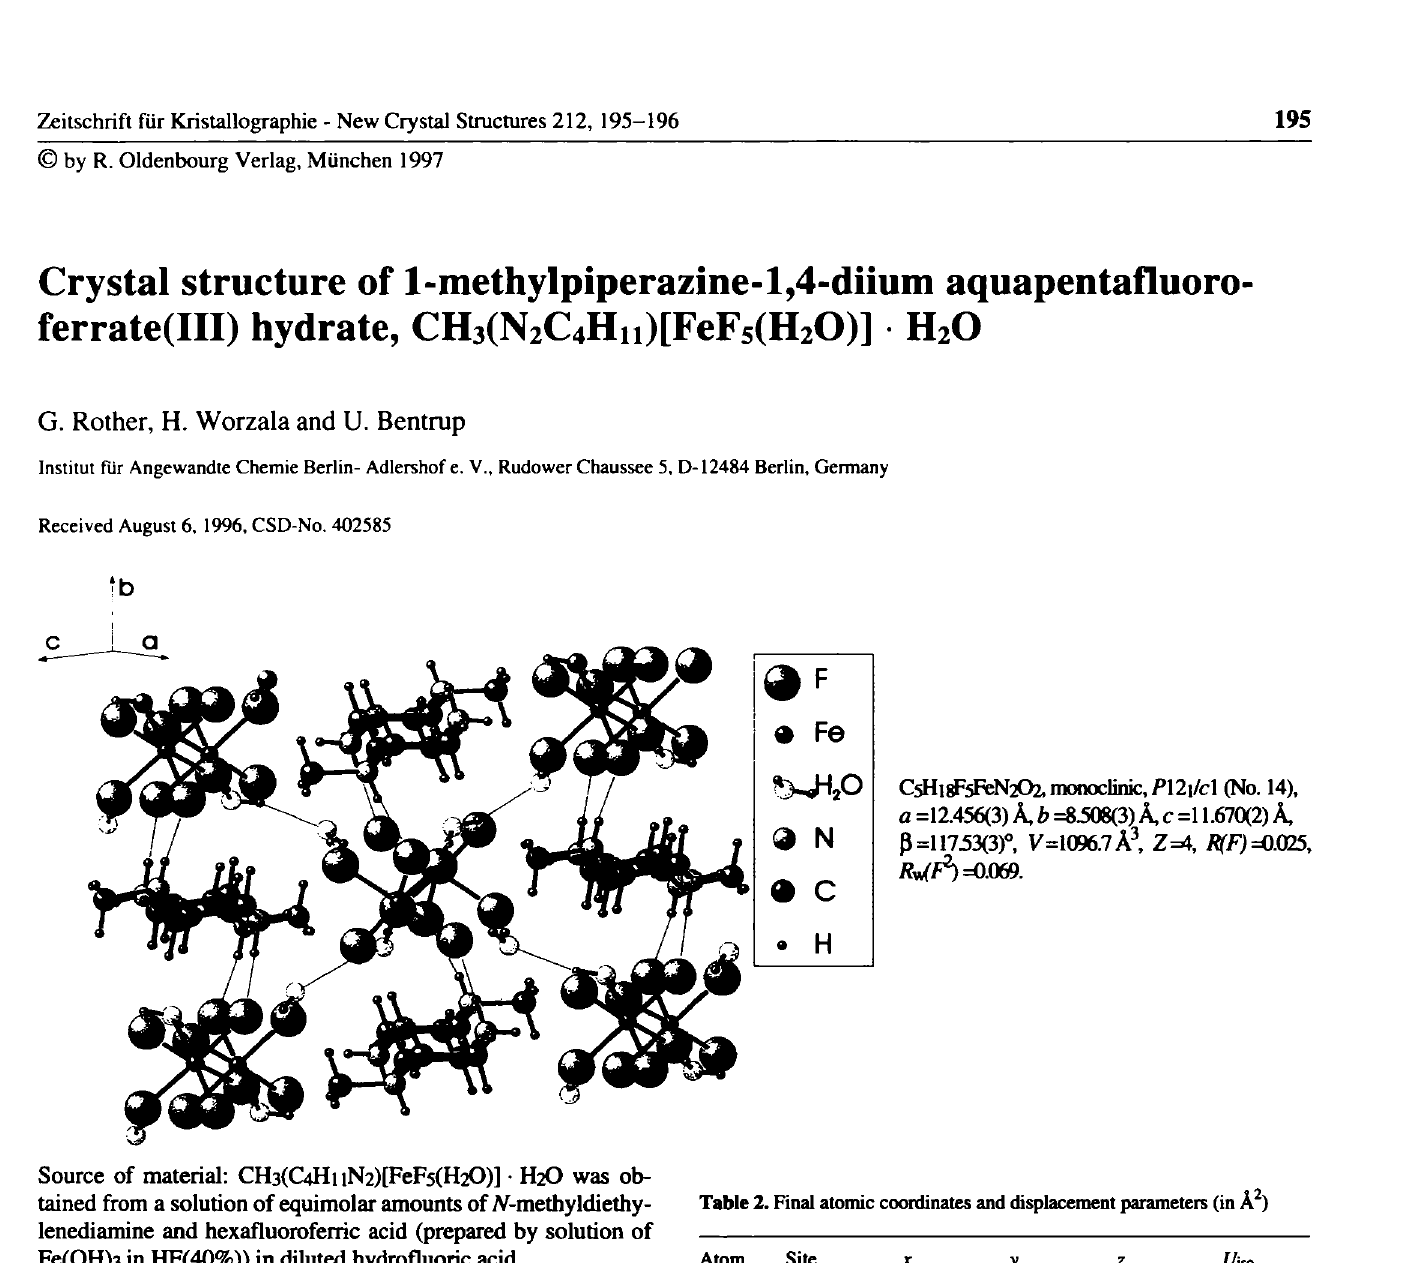
Table 1. Parameters used for the X-ray data collection Crystal: